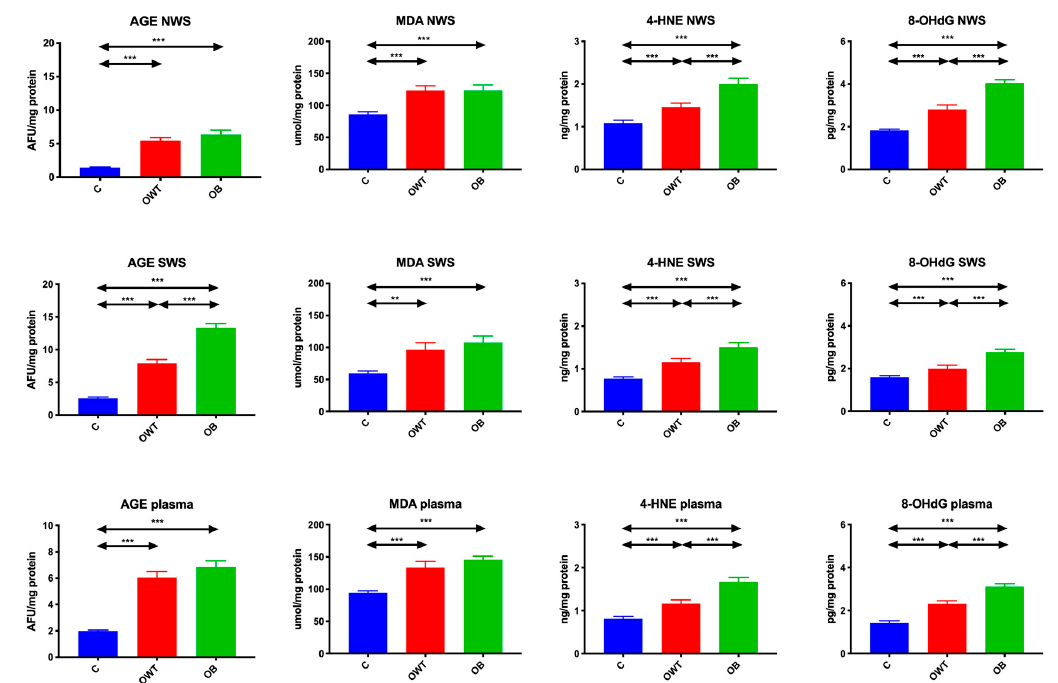
Figure 5. Protein, lipid, and DNA oxidation products in overweight and obese adolescents as well as healthy controls. AGE- advanced glycation end products, C- control, MDA- malondialdehyde, NWS- non-stimulated whole saliva, OB- obese, OWT- overweight, SWS- stimulated whole saliva, 4-HNE- 4-hydroxynoneal protein adduct, 8-OHdG- 8-hydroxy-D-guanosine. Differences statistically significant at: ** p < 0.005, *** p < 0.0005.